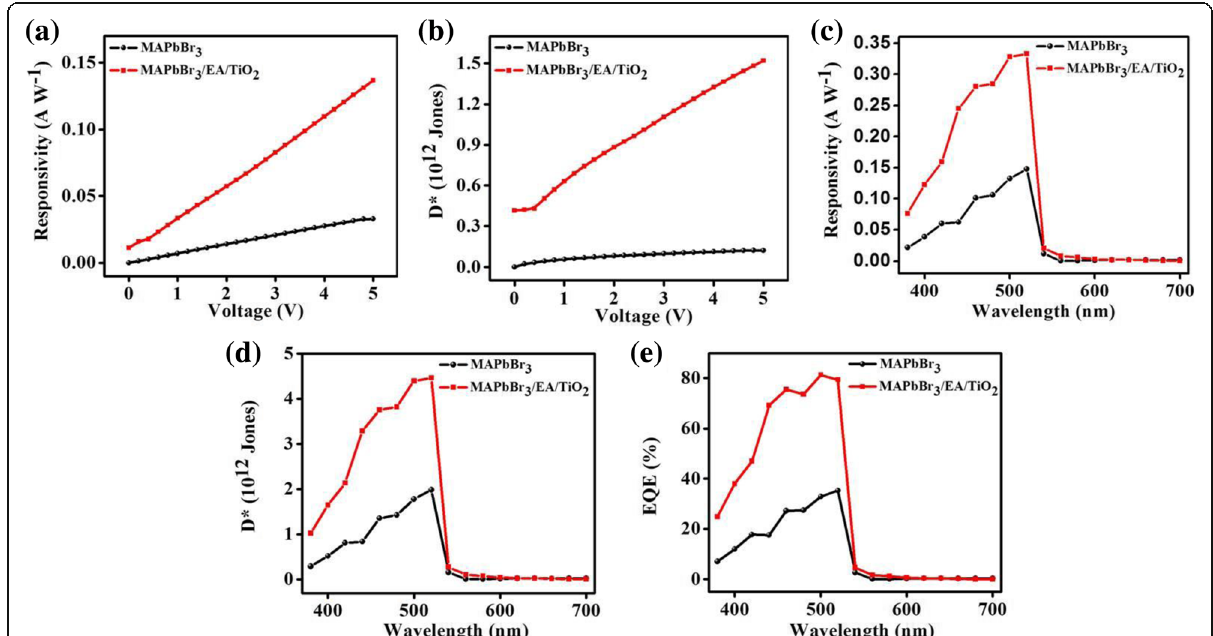
Fig. 5 a Responsivity and ( b ) detectivity of single and trilayer devices at different applied voltage under light intensity of 0.5 mW cm − 2 . c Spectral responsivity, d spectral detectivity, and ( e ) EQE spectra of two photodetectors under light illumination of 10.6 μ W cm − 2 and a bias of 5